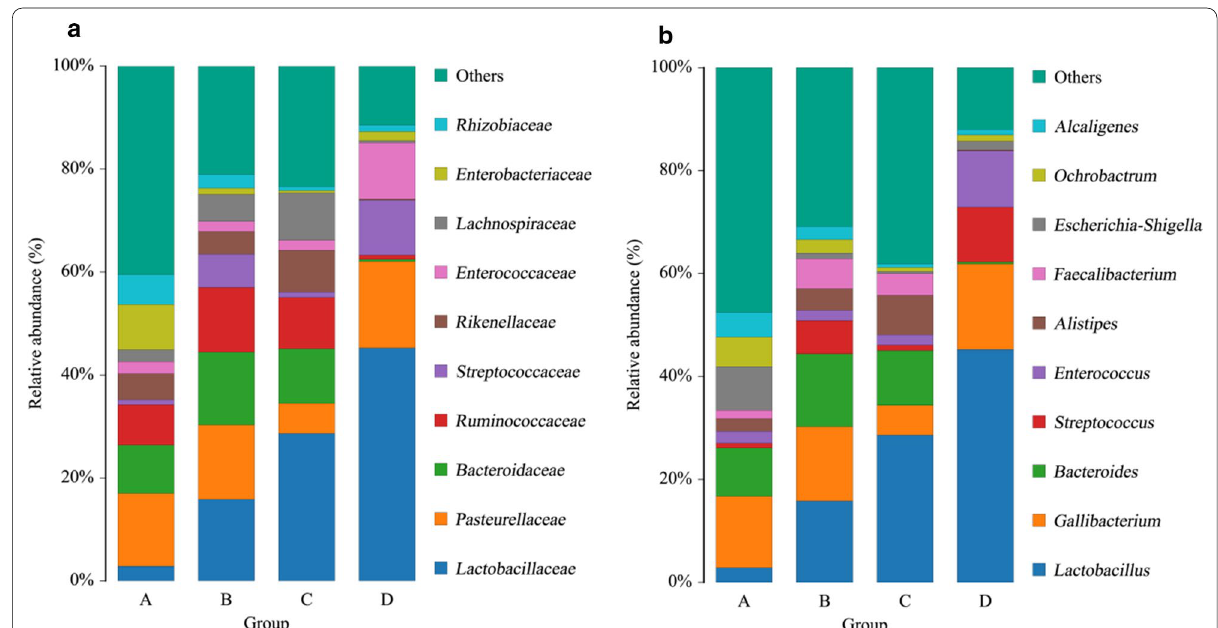
Fig. 4 Histogram of the distribution of species. a , b Indicate the community composition of gut microbiota at the family and genus levels, respectively. The abscissa represents the group, and the ordinate represents the relative abundance. One color represents one species, the length of the color block present the relative richness proportion of the species. The figures show species with top ten richness levels, and the rest species